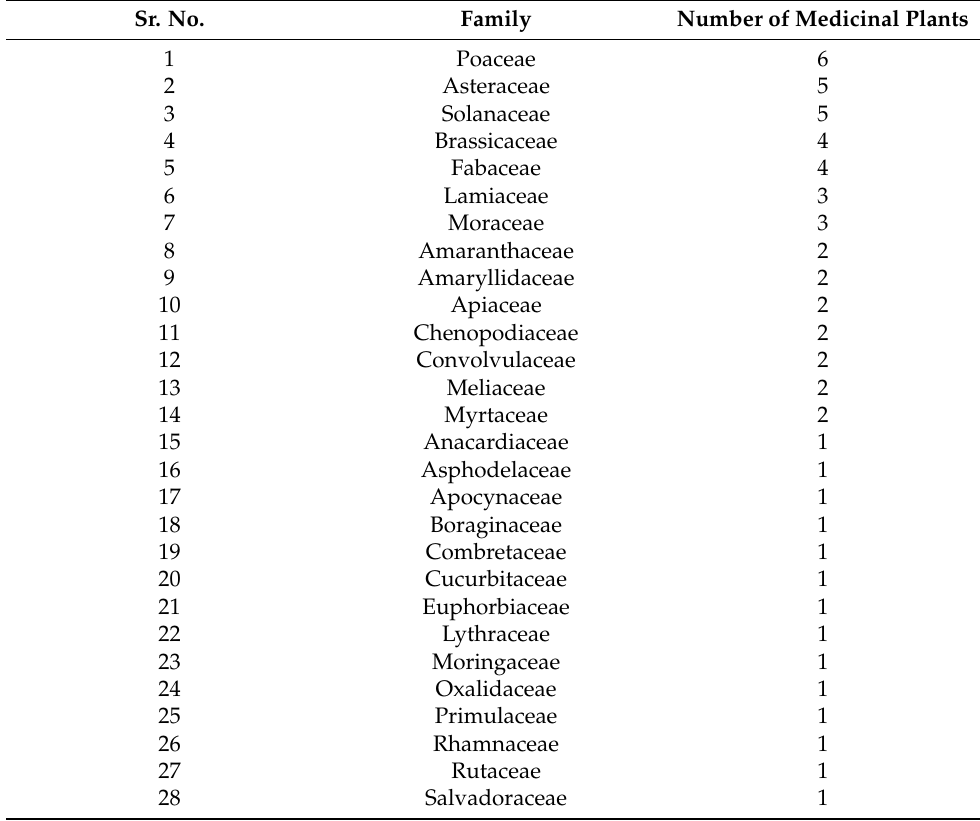
Table 2. Families representing the number of medicinal plants.